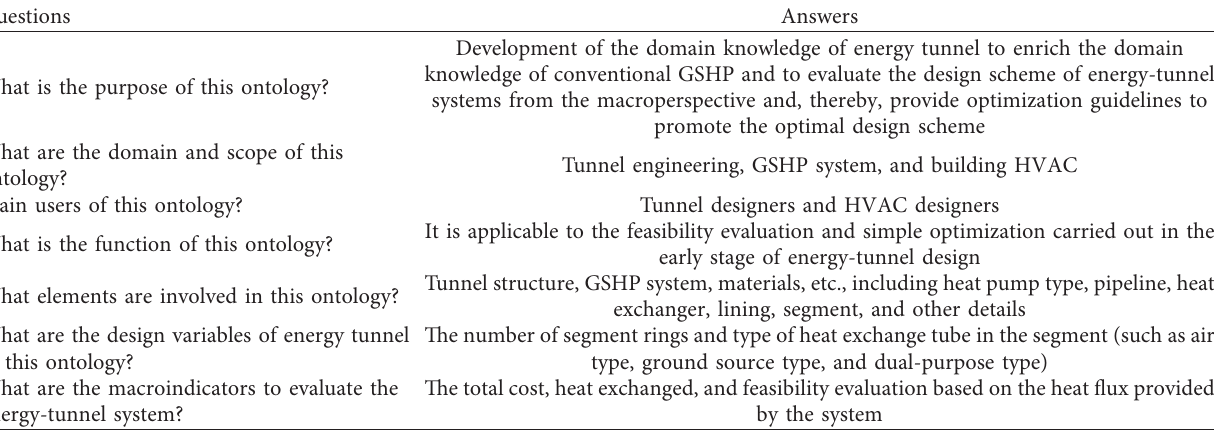
Figure 3: UML flowchart of the OntoETS comprehensive decision-making system. Table 2: Question table for knowledge identification of the energy-tunnel